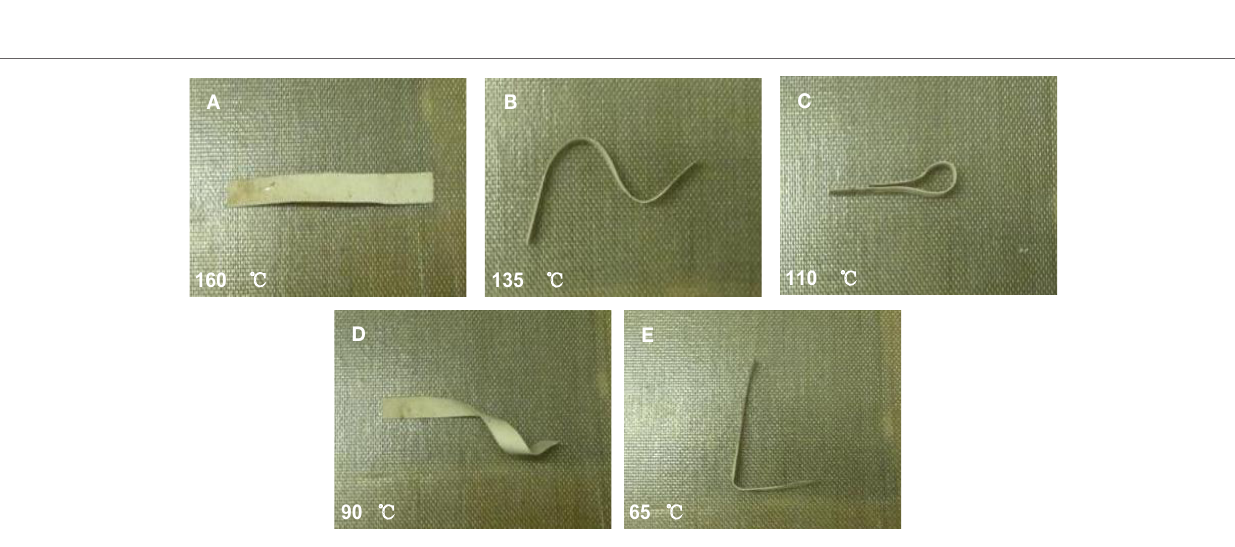
FiGURe 6 | Photos of electrospun Nafion nanofiber membranes with quintuple-shape memory effect. (Zhang et al., 2013b, © IOP Publishing. Reproduced with permission. All rights